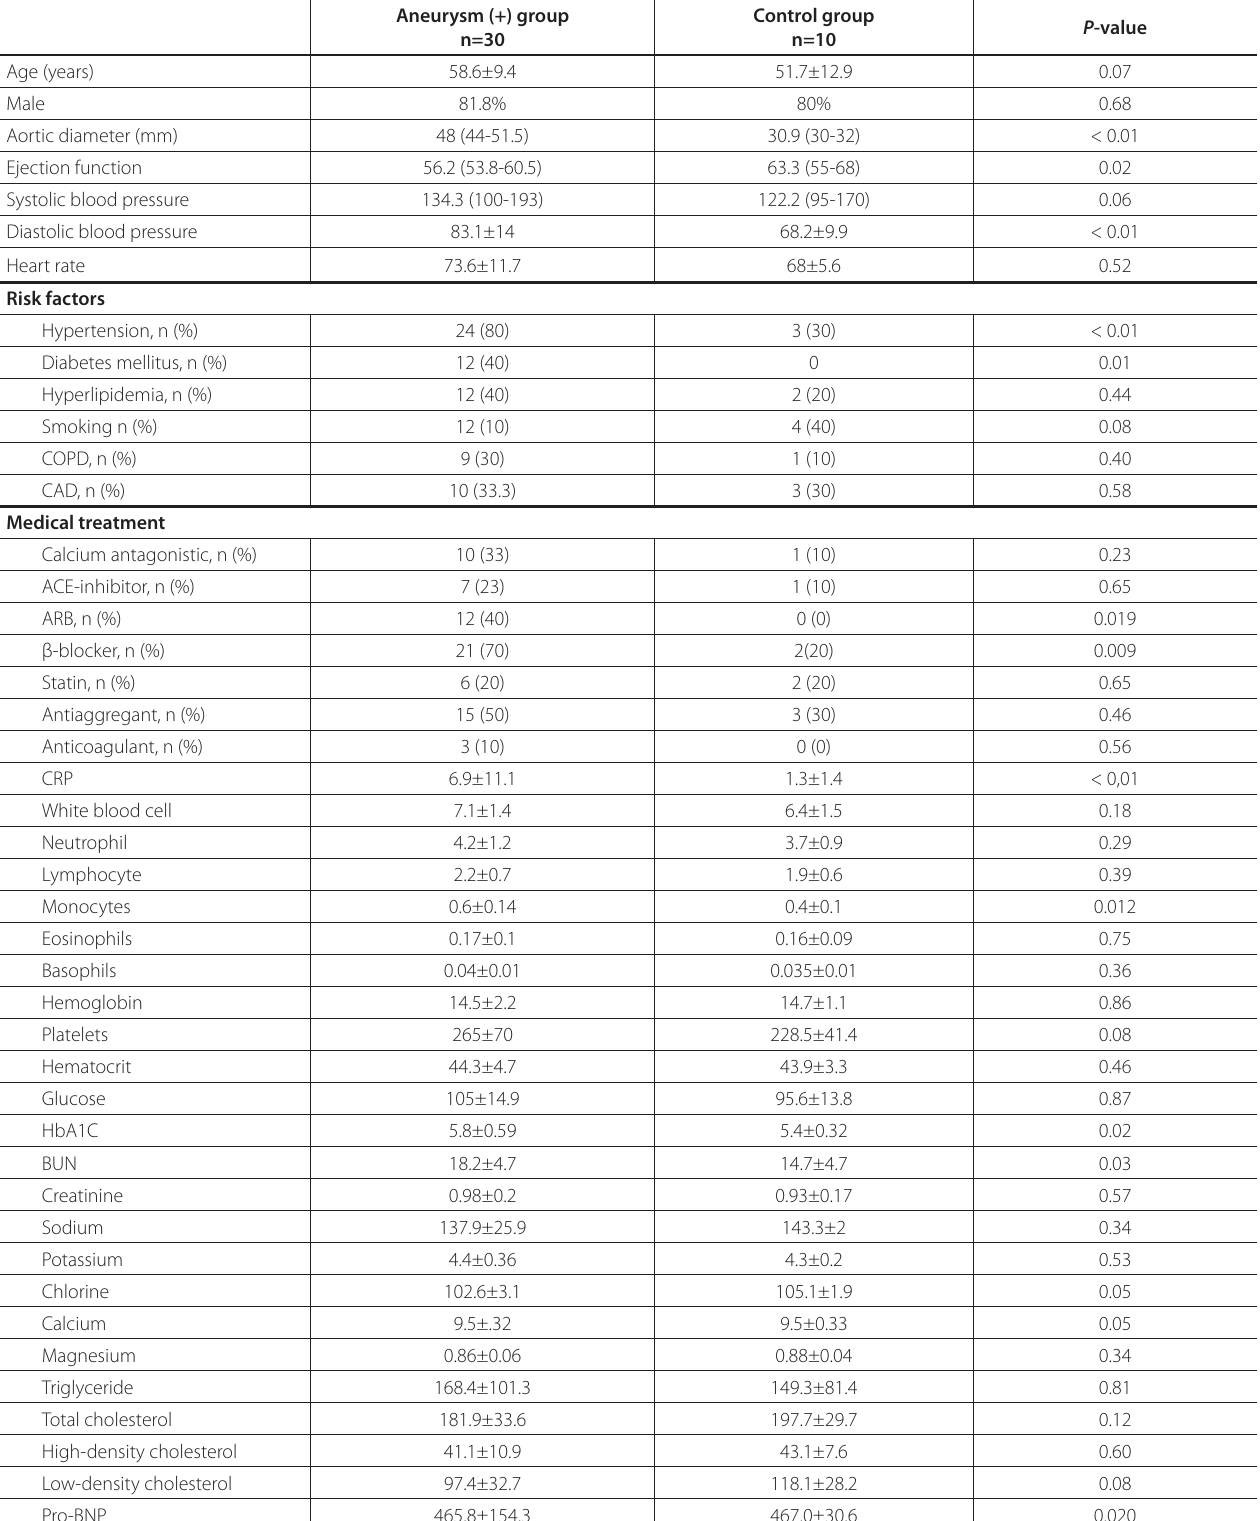
Table 1 . Risk factor, echocardiogram, and laboratory findings of patient and control